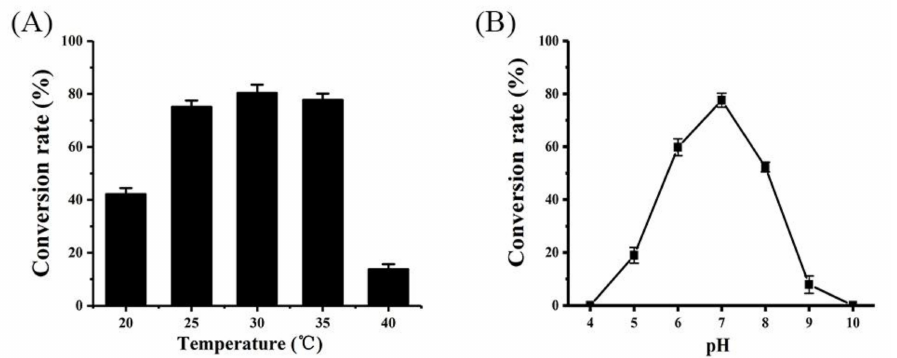
Figure 4. Effects of ( A ) temperature and ( B ) pH on α -arbutin conversion rate. All assays were performed in triplicate in three independent experiments. Standard deviations of biological replicates are represented by error